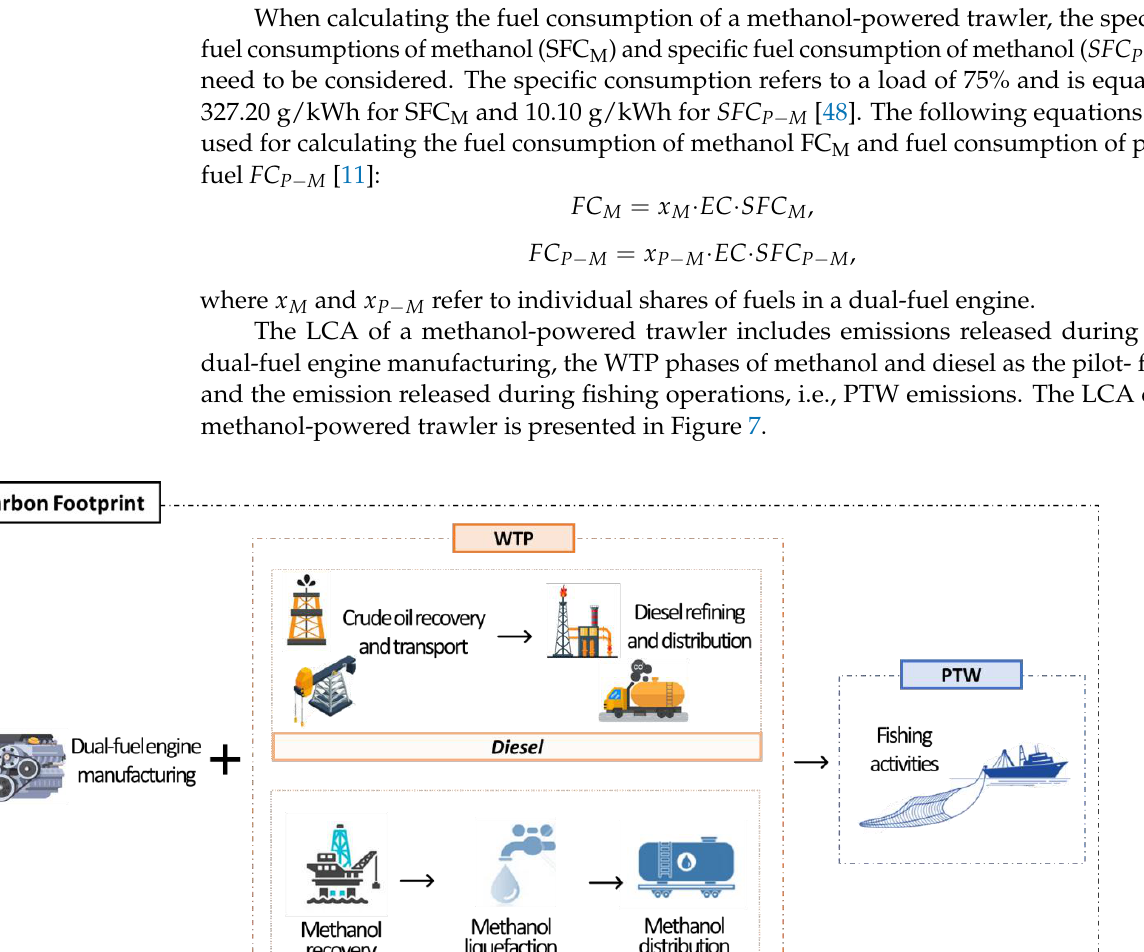
Figure 6. The Croatian electricity mix (2020).